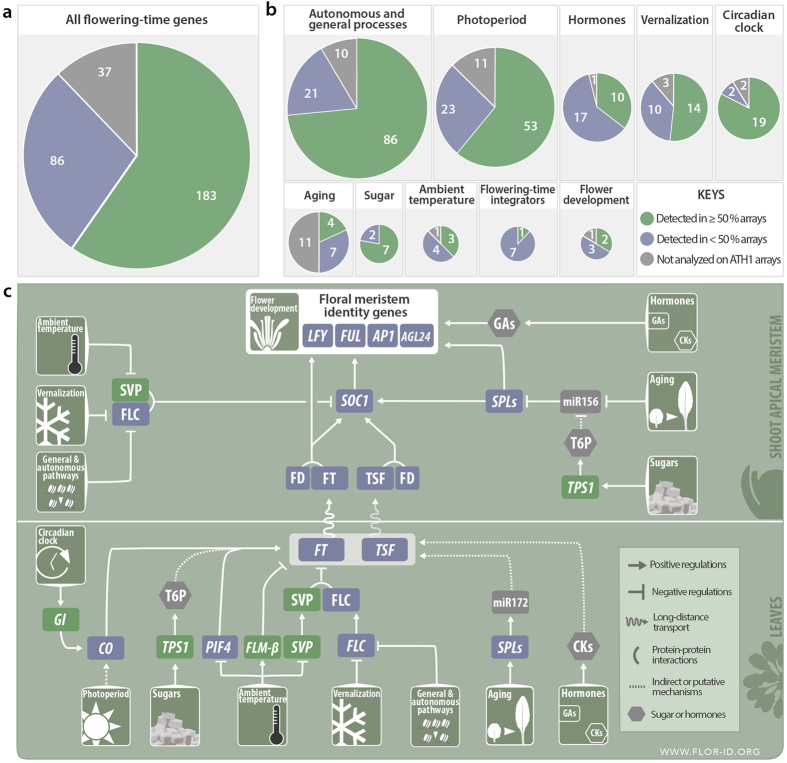
Flowering-time genes expressed in the roots of Arabidopsis thaliana.Genes expressed in the roots were identified by a present/absent call on 1,601 root ATH1 arrays retrieved from ArrayExpress repository (https://www.ebi.ac.uk/arrayexpress/). Flowering-time genes were extracted from FLOR-ID. (a) All 306 flowering genes. (b) Pie charts showing the same set of genes classified into flowering time pathways, circadian clock and flower development. Some genes are involved in more than one pathway. Pie chart area is proportional to gene number. (c) The snapshot of flowering pathways was extracted and adapted from FLOR-ID. Genes highlighted in green boxes were detected in ≥50% of root arrays. Genes in blue boxes were detected in <50 % arrays. Genes and compounds not analyzed in ATH1 arrays are in grey.